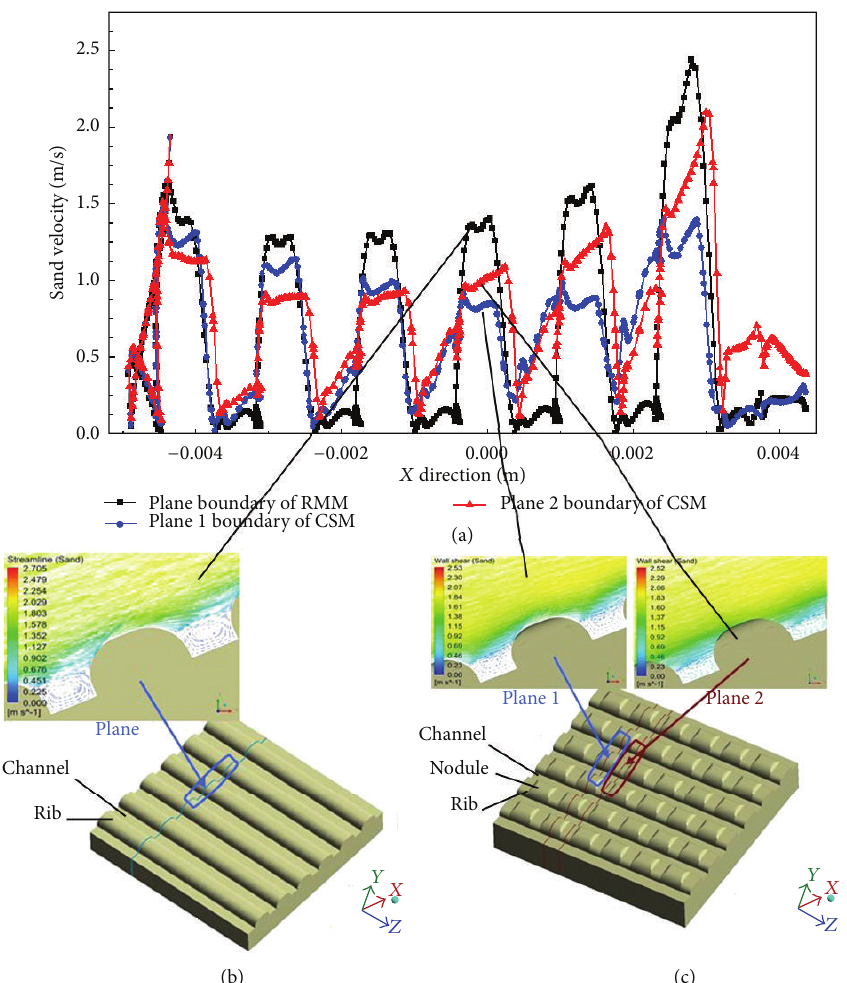
Figure 7: Fluid velocity of two models in x direction: (a) sand velocity on different plane boundaries of two models; (b) velocity vector on the plane of RMM; and (c) velocity vector on the plane 1 and plane 2 of